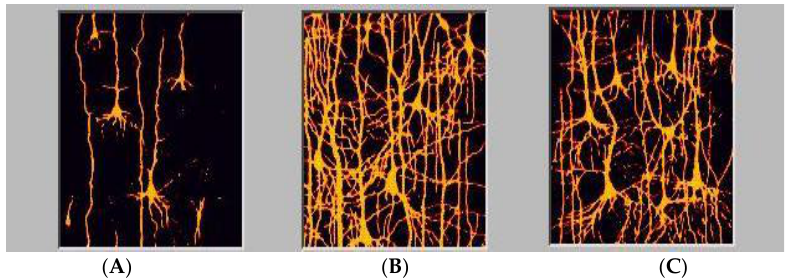
Figure 2. We see the complexity of dendritic structures of cortical neurons consistent with expansion of synaptic connectivities as a function of age. ( A , 5 days; B , 6 years, C , adult) [21]. What we can learn from these changes in connectivities is that the child learner has significant degree of flexibility in making hard-wired connections. If one were to ask an elementary school child to imagine a dolphin bouncing a pineapple on its snout, neuro- logically it would represent a complex problem requiring sophisticated coordination in- side of the child’s brain. The reason being is that in order to create a novel unusual image, the child’s brain would be required to take familiar pieces and assemble them in new ways. That is because in order to create these strange new images the child’s brain would have to take familiar pieces and assemble them in novel ways — like a collage made from fragments of photos. The child’s brain would be required to juggle a sea of thousands of electrical signals — getting them all to their destination at precisely the right time. It turns out that this is actually a complex problem that requires sophisticated coordination inside of our brains. The brain has to negotiate a sea of electrical signals getting them all to their destination at precisely the right time. When we look at an object, thousands of neurons in our posterior cortex fire. These neurons encode various characteristics of the object — spiky, fruit, brown, green, and yel- low. Synchronous firing strengthens the connections between that set of neurons linking them together into what is known as a neuronal ensemble. In this case — the one for pine- apple.[38] We can hypothesize and state that in a theory of mental synthesis — timing is key [39 – 41]. If the neuronal ensembles for the dolphin and the pineapple are simultaneously acti- vated, the child could perceive the dolphin and the pineapple simultaneously. Without synchronization, the pineapple and dolphin would be asynchronous — two separate ob- jects but not a single image. Something in the child’s brain has to coordinate that firing. A plausible candidate is the prefrontal cortex — which is involved in all complex cognitive functions. Prefrontal cortical neurons are connected to the posterior cortex by long spindly neural fibers with the prefrontal cortical neurons sending electrical impulses down these fibers to multiple ensembles in the posterior cortex thereby activating them in unison. If the neuronal ensembles are turned on at the same time, then the child would experience the composite image as if he or she had actually seen it. This conscious purposeful syn- chronization of different neuronal ensembles by the prefrontal cortex is an example of mental synthesis. In order for mental synthesis to work, signals would have to arrive at both neuronal ensembles simultaneously. The problem is that some neurons are much further away from the prefrontal cortex than others. If the signals traveled down both fibers at the same time they would arrive out of sync. One cannot change the length of the connections but the brain — especially as it de- velops in childhood — does have a way to change the conduction velocity. Neural fibers are wrapped myelin, Myelin as an insulator can speeds up the electrical signals. Some nerve fibers have as many as one hundred layers of myelin while others only have a few and fibers with thicker levels of myelin can conduct signals as much as 100 times faster or more than those with thinner ones. We have begun to think that this difference in